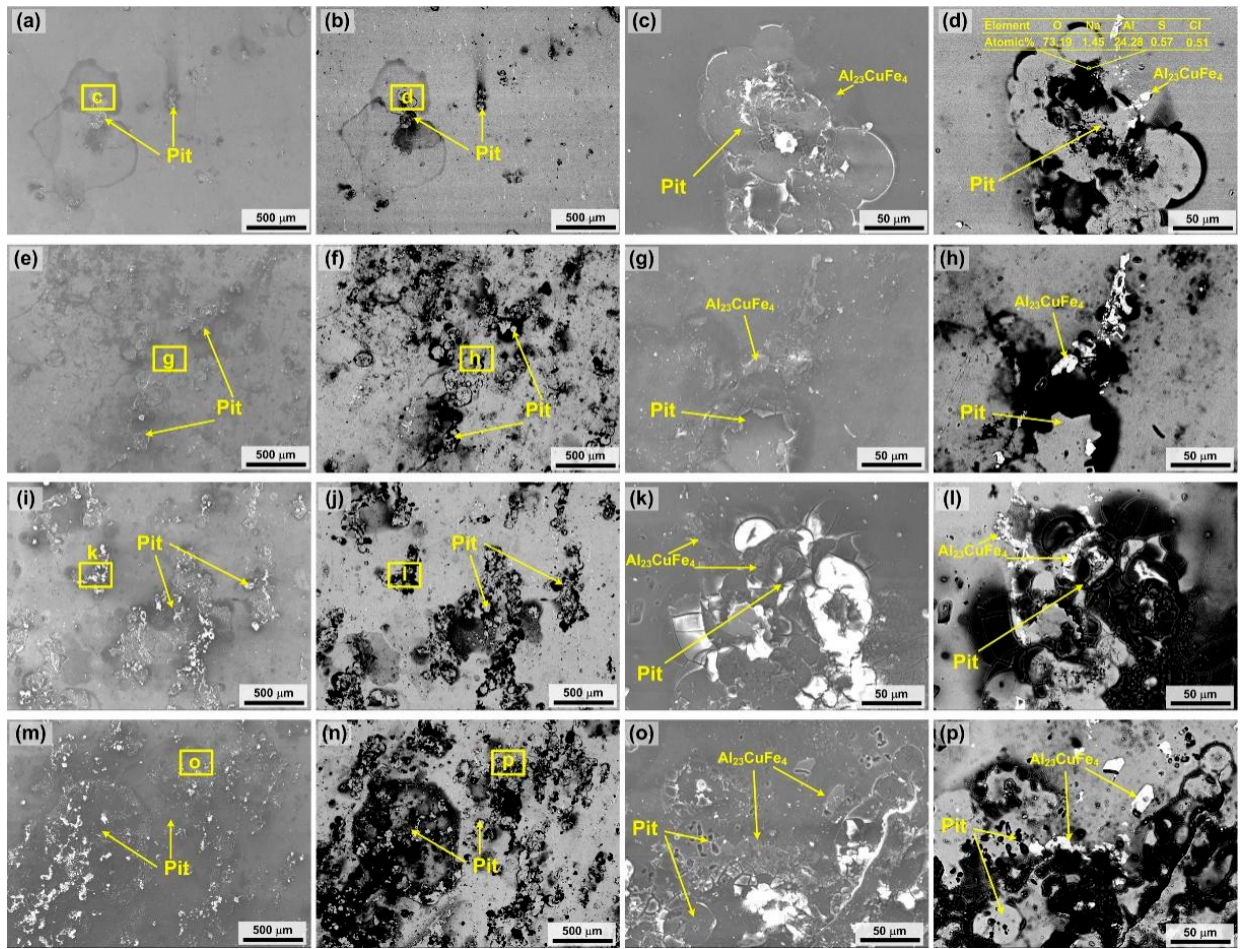
Figure 5. SEM secondary electron and backscattered electron images of the surface morphologies of 7075 aluminum alloy specimens exposed outdoor for different numbers of days: ( a – d ) 15 days; ( e – h ) 30 days; ( i – l ) 90 days; ( m – p ) 180 days.